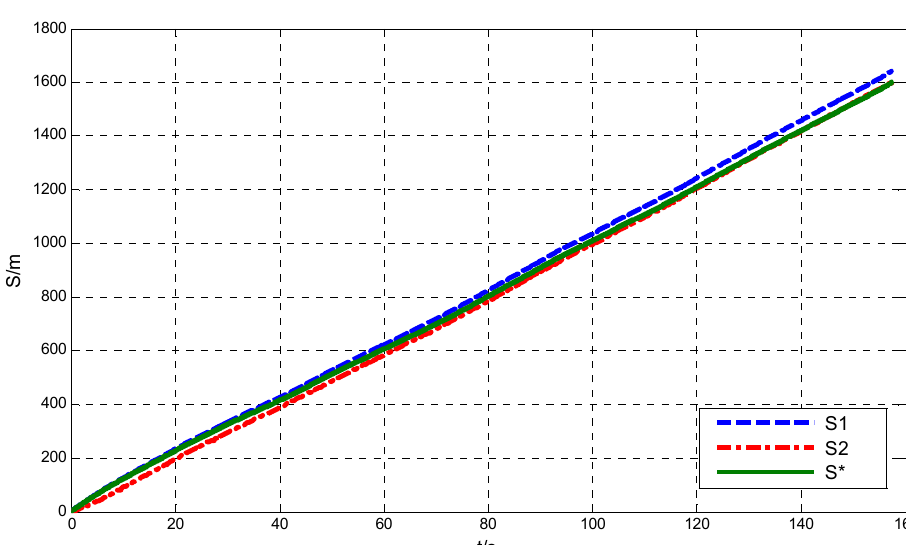
Figure 10. Distance histories before and after